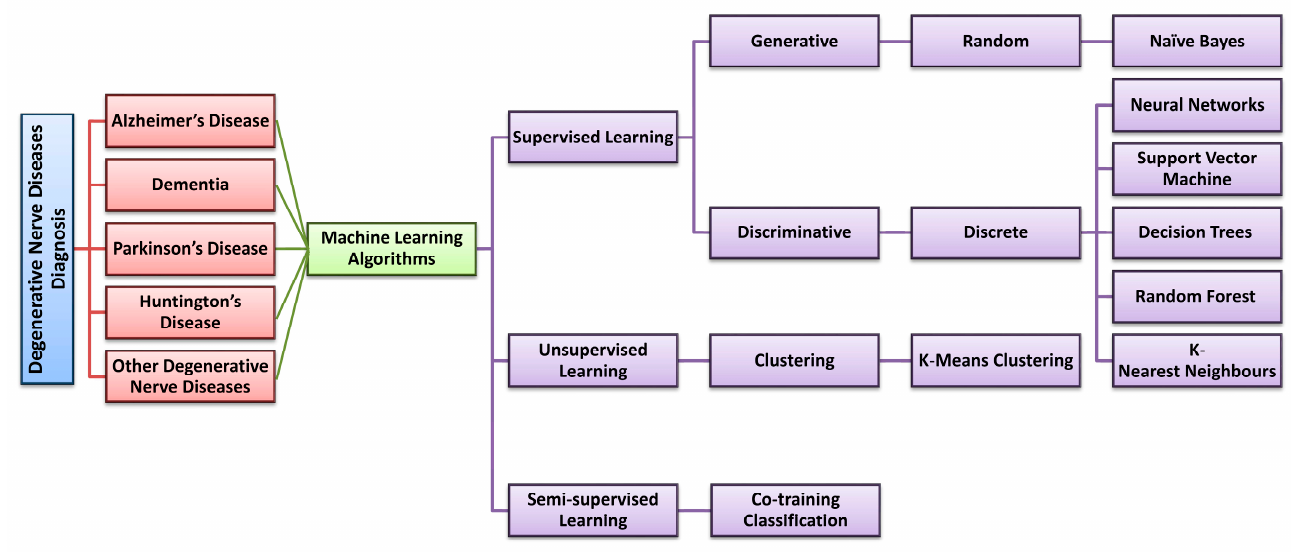
Figure 4. Machine learning models used for degenerative nerve disease diagnosis in this review: a tree illustration.